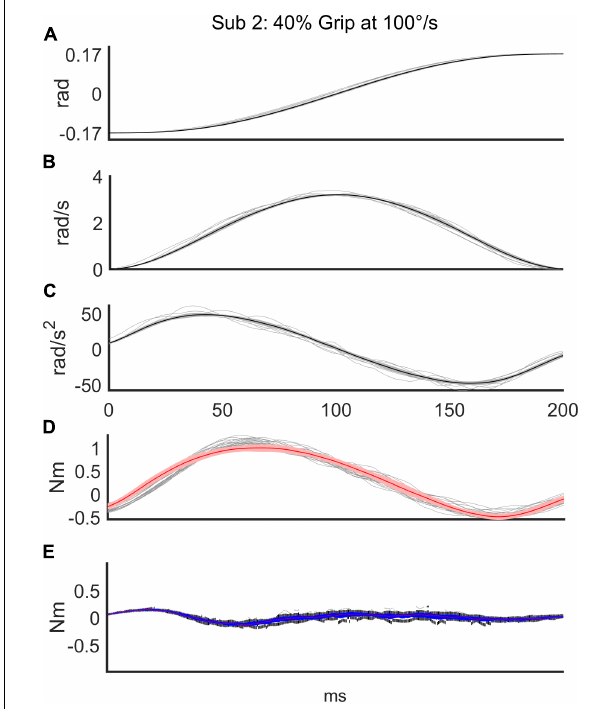
FIGURE 3 | Representative subject’s (Subject 2) recorded signals for a sequence of 56 trials in the condition of slow (100 ◦ /s) perturbations at 40% Grip. The top three subplots show the time course of angular displacement (A) , velocity profile (B) , and acceleration profile (C) of the perturbations (thin: measured values; thick: mean value). The bottom two subplots demonstrate the power of the curve fitting of the model-estimated torque profile (red line) on top of the measured torque profiles (gray lines) (D) and the time-course of the discrepancy between the two torque profiles (E) .